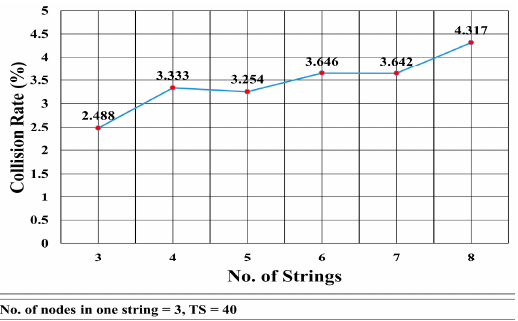
Figure 16. Percentage of Collision Rate vs. No. of Strings.